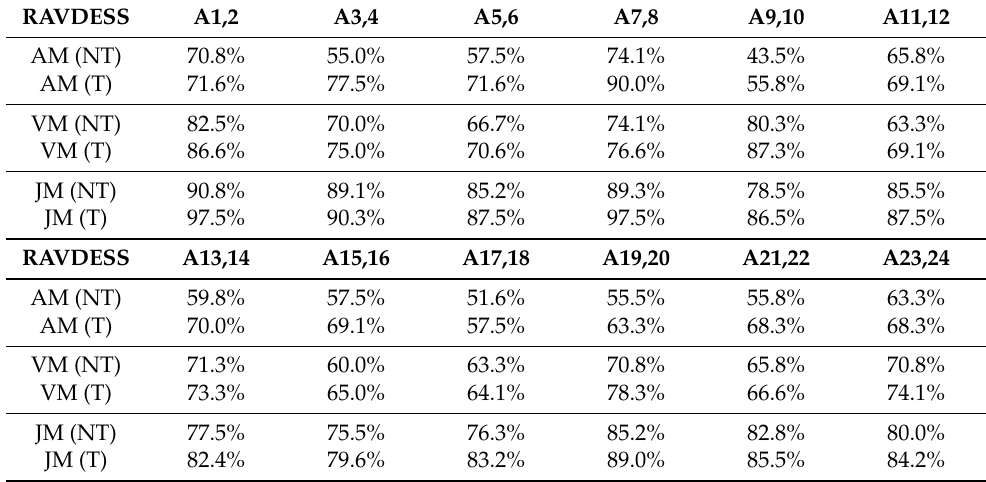
Table 1. Comparison of single modalities models with N 0 model (RAVDESS cases): VM—Visual Modality only; AM—Audio Modality only; JM—Joint Modalities ( N 0 model); T—having